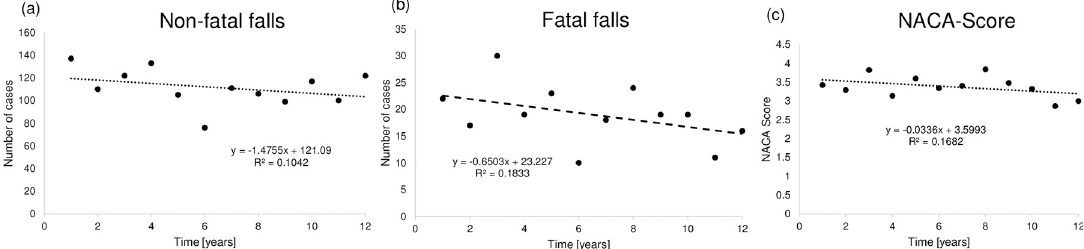
Fig 2. (a) Development of all falls over the observational period (b) Development of fatal falls over the observational period (c) Development of NACA-Score over the observational period. The score indicates the severity of injuries. Abbreviations: NACA-Score, National Advisory Committee for Aeronautics